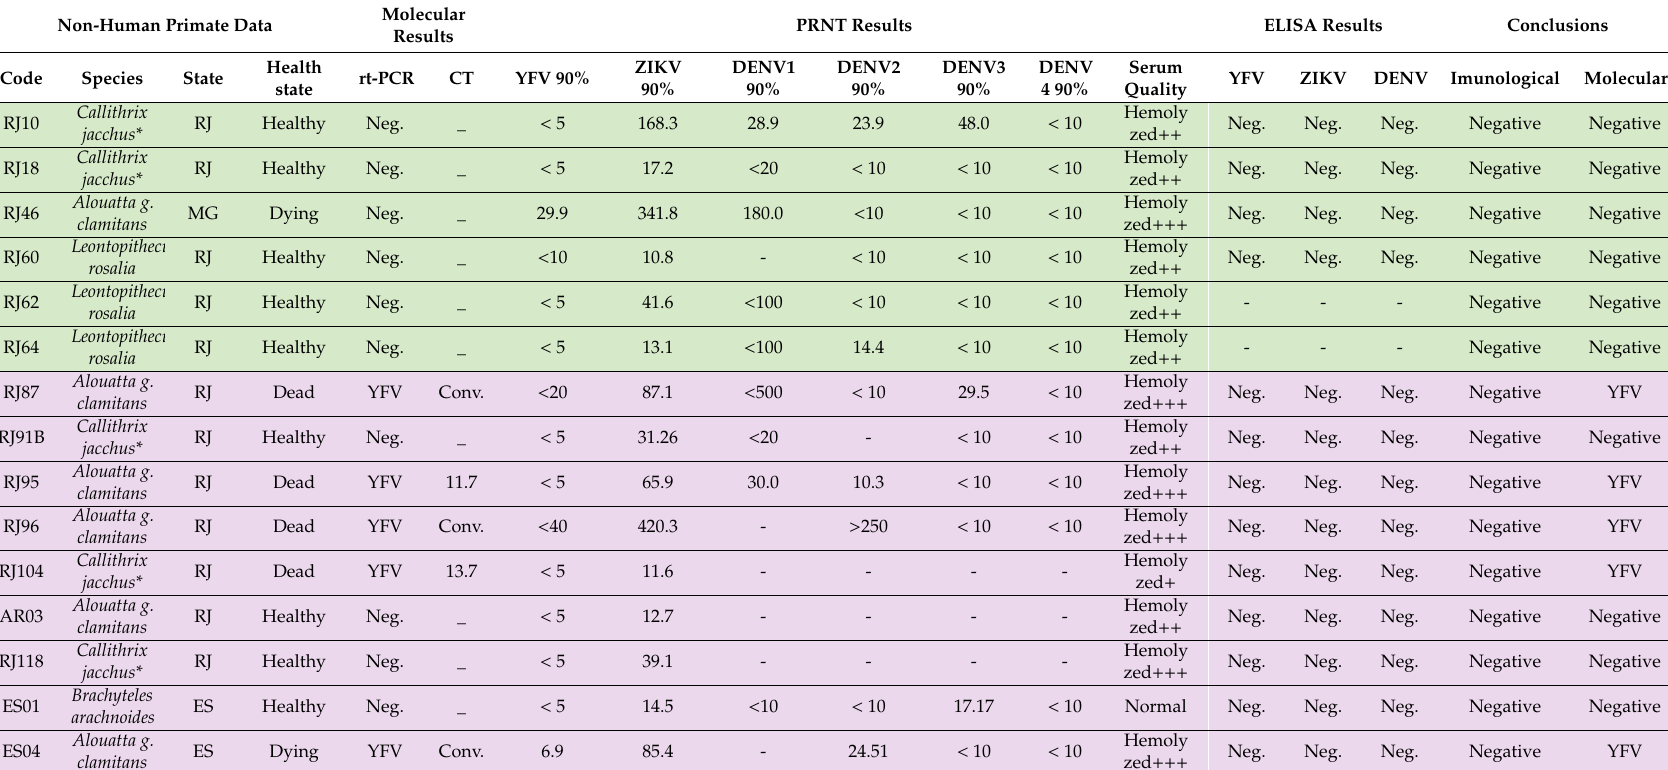
Table 2. List of samples that showed unspecific response during the PRNT 90 assays for tested